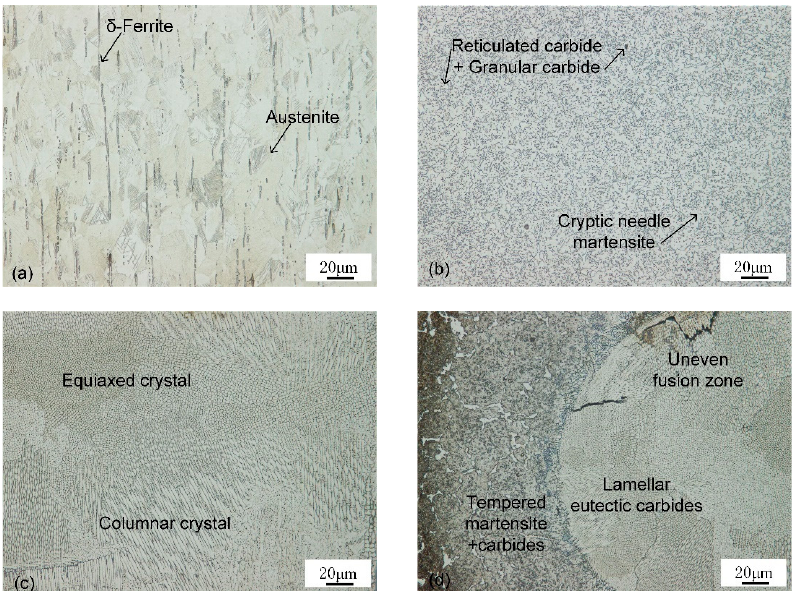
Figure 10. Microstructure analysis of different areas: ( a ) 303Cu BM, ( b ) 440C-Nb BM, ( c ) middle of weld, ( d ) bottom of weld.